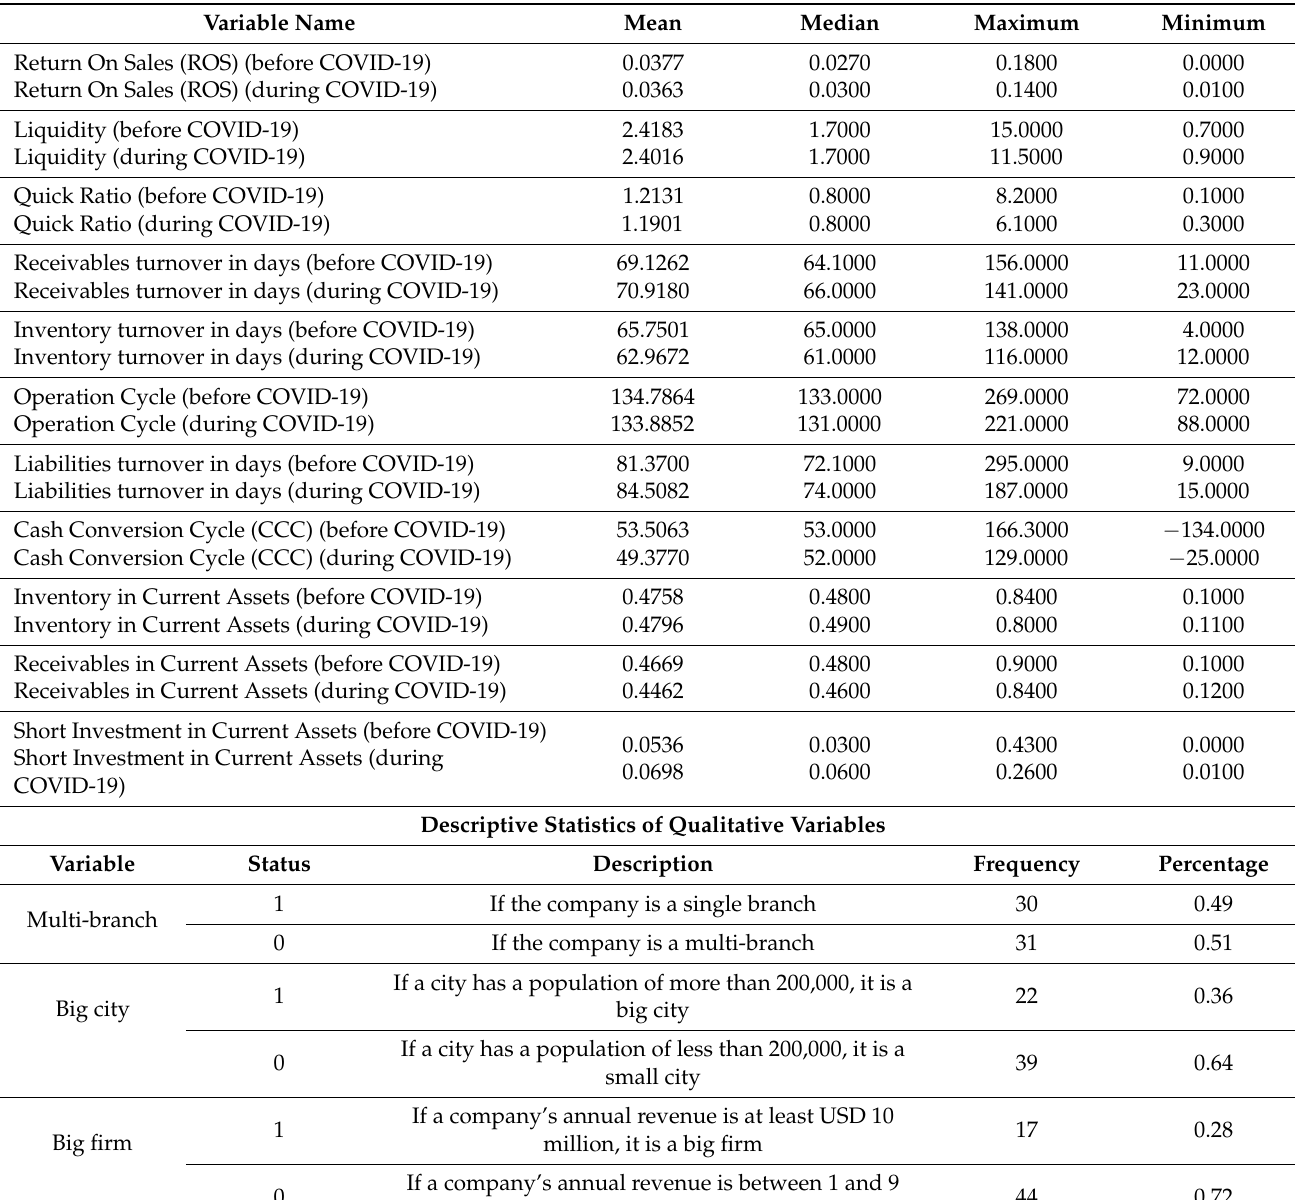
Table 1. Comparative descriptive